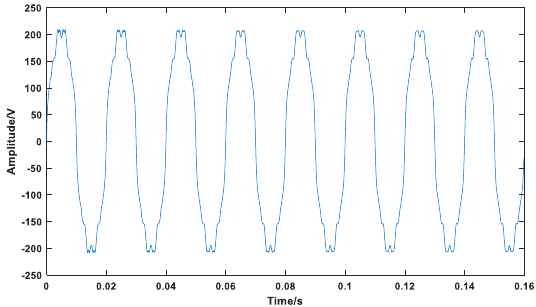
( ) S t waveform is shown in Figure 4.